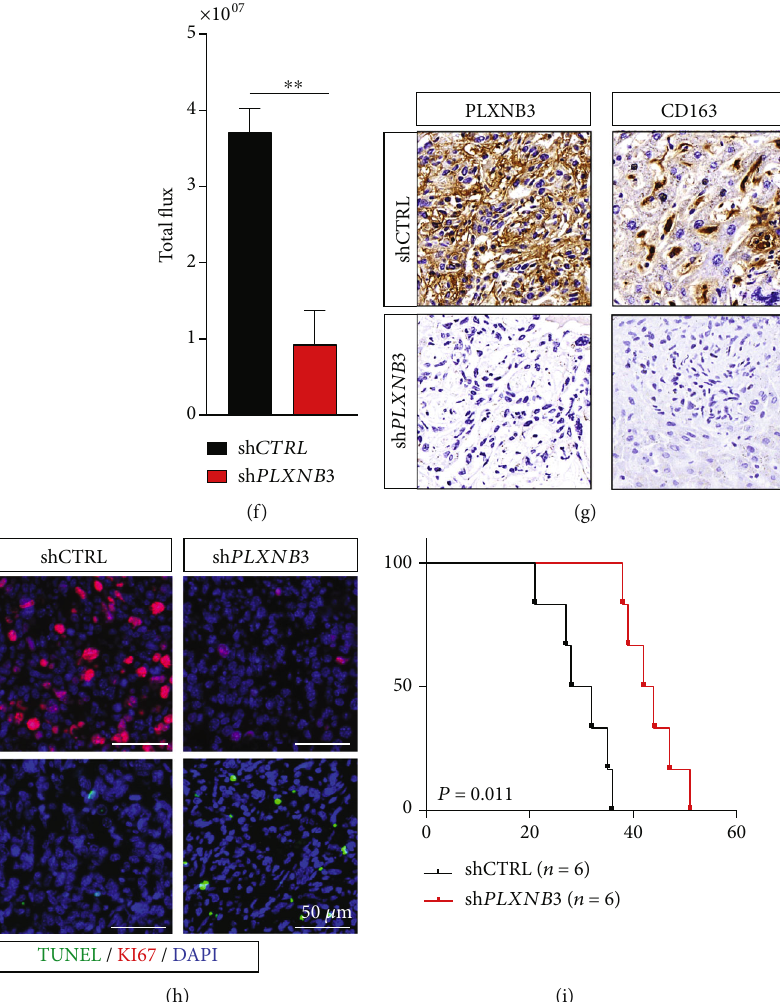
Figure 3: SEMA5A-PLXNB3 axis promotes liver metastasis in vivo. (a) The coexpressions of CK19 and PLXNB3 were performed by IF staining in spontaneous PDAC liver metastasis KPC mouse model ( n = 6 mice, 3 fi elds assessed per sample). CK19, green; PLXNB3, red; DAPI, blue; scale bars, 50 μ m. (b) Real-time PCR measured mRNA levels of SEMA5A and PLXNB3 in human normal pancreas epithelial cell line HPNE, human PDAC cell line PANC1, CAPAN1, BxPC3, and AsPC1 and murine PDAC cell line KPC1199 and Panc02. (c, d) CT combined in vivo imaging with organ reconstruction assessed liver metastasis burdens of intrasplenic injection mouse model ( n = 6 mice per group). Scale color bars: 5 : 00 × 10 [4] − 3 : 00 × 10 [5]. Reconstructed liver, red; reconstructed spleen, orange;